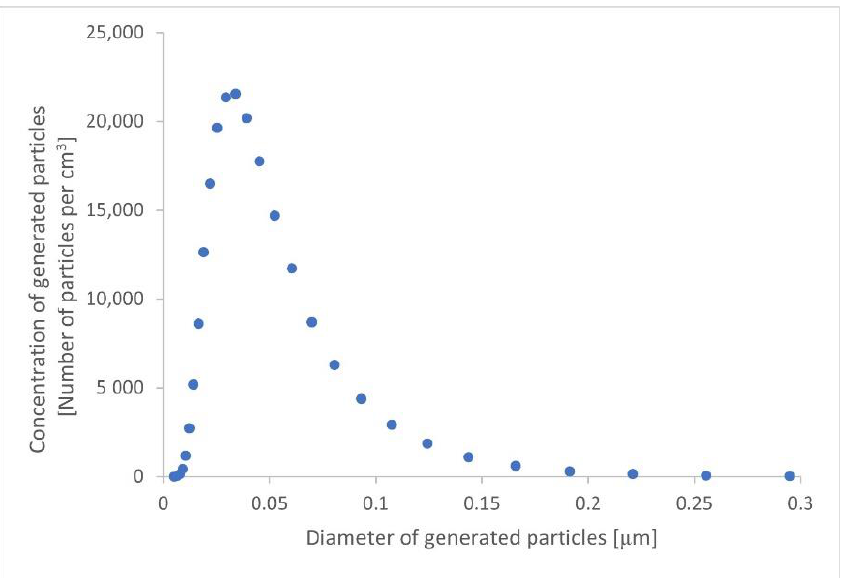
Figure 4. KCl particles size